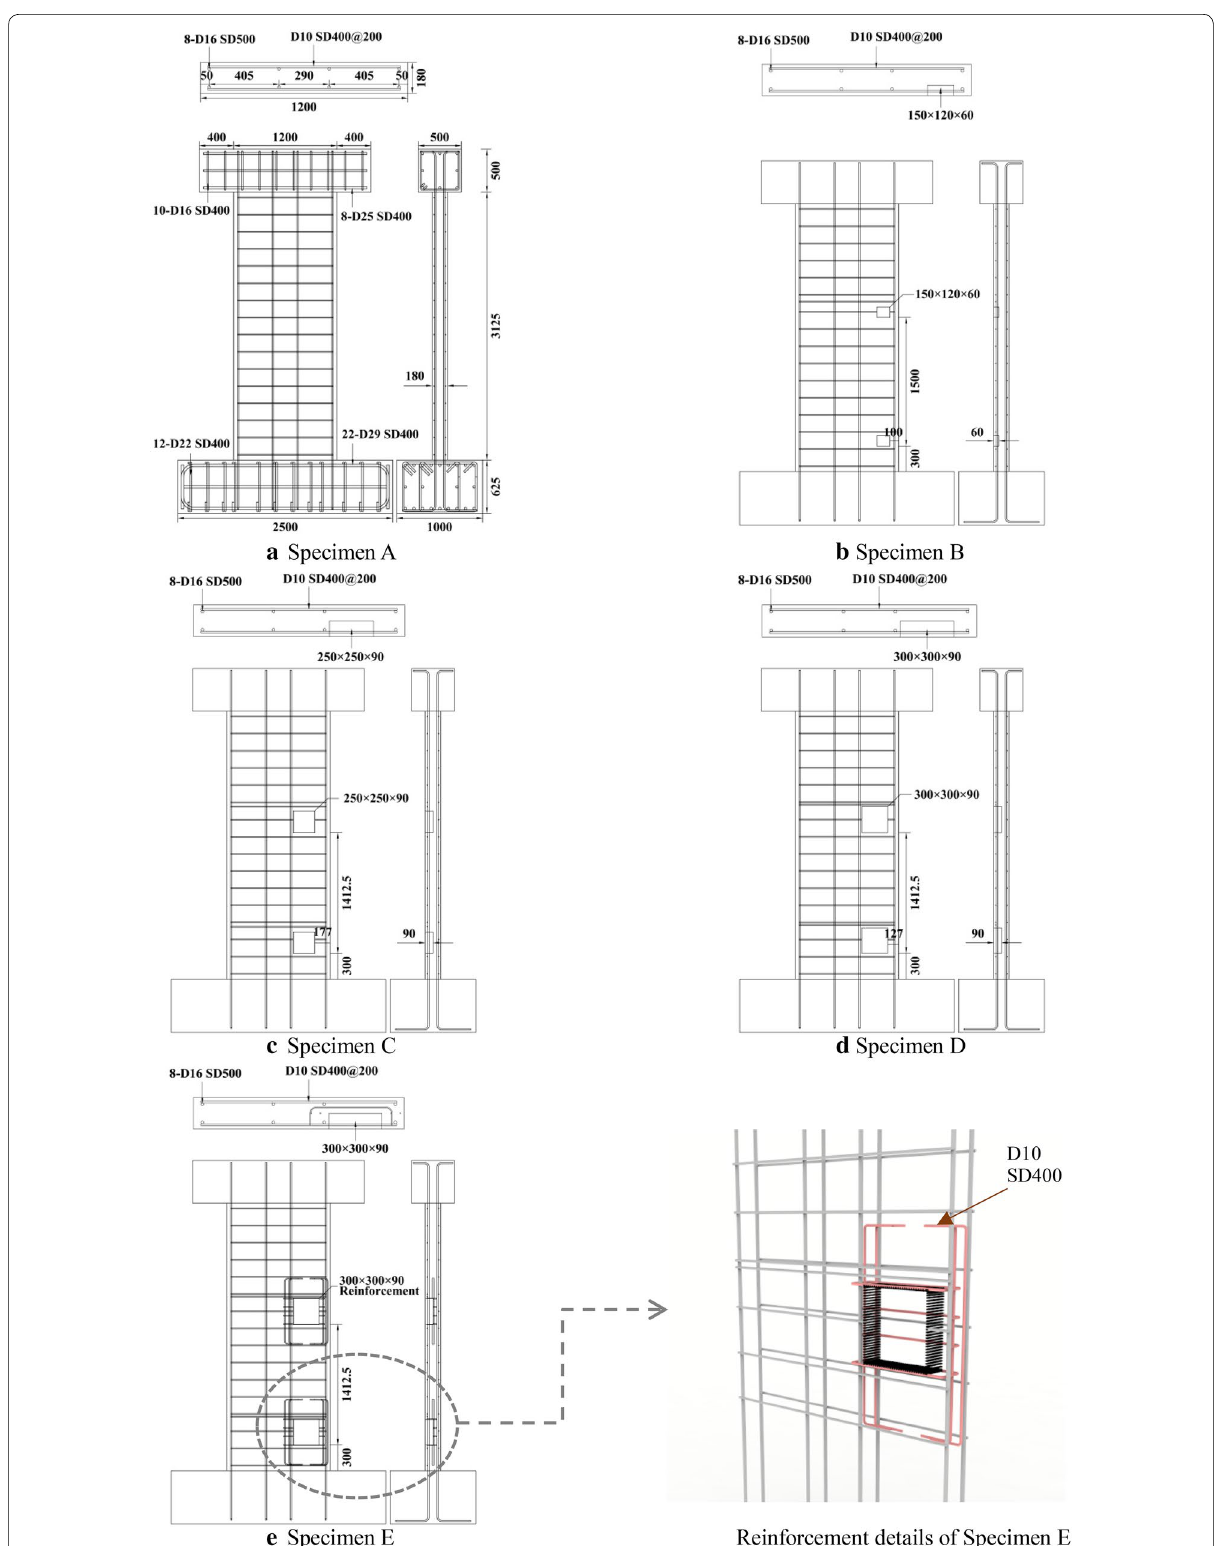
Fig. 4 Details of test